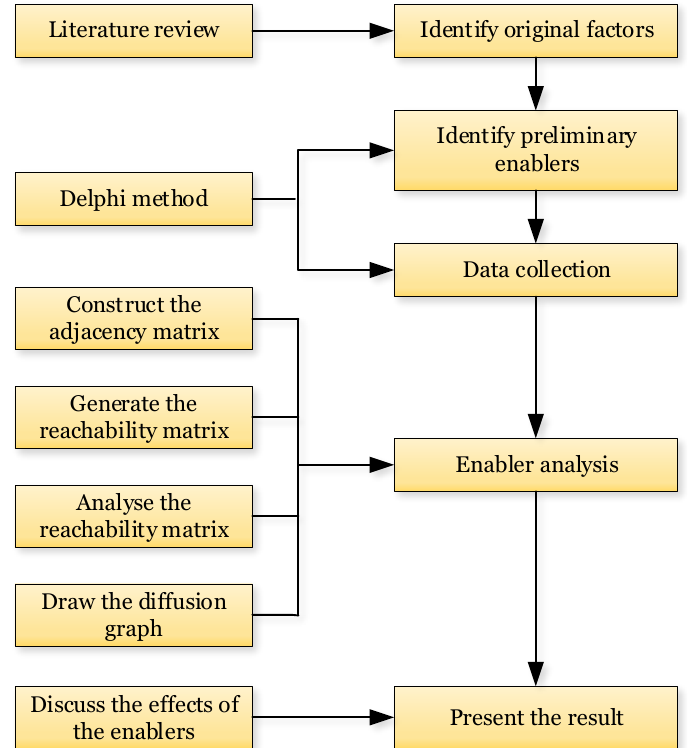
Figure 1. The overarching framework of this